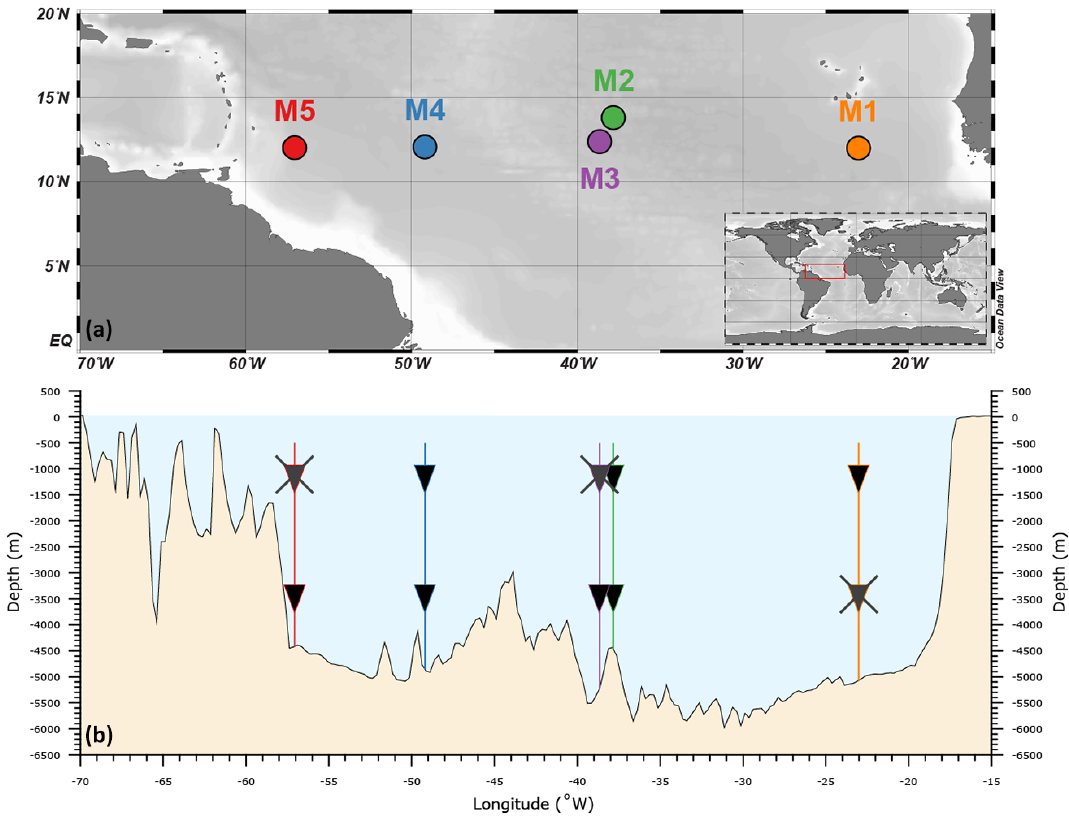
Figure 1. (a) Map with sampling stations M1–M5 in the Atlantic Ocean at 12 ◦ N. (b) Bathymetry along 12 ◦ N (from http://www.gebco.net) with sediment traps at 1200m and 3500mb.s.l. Crossed-out sediment traps could not be